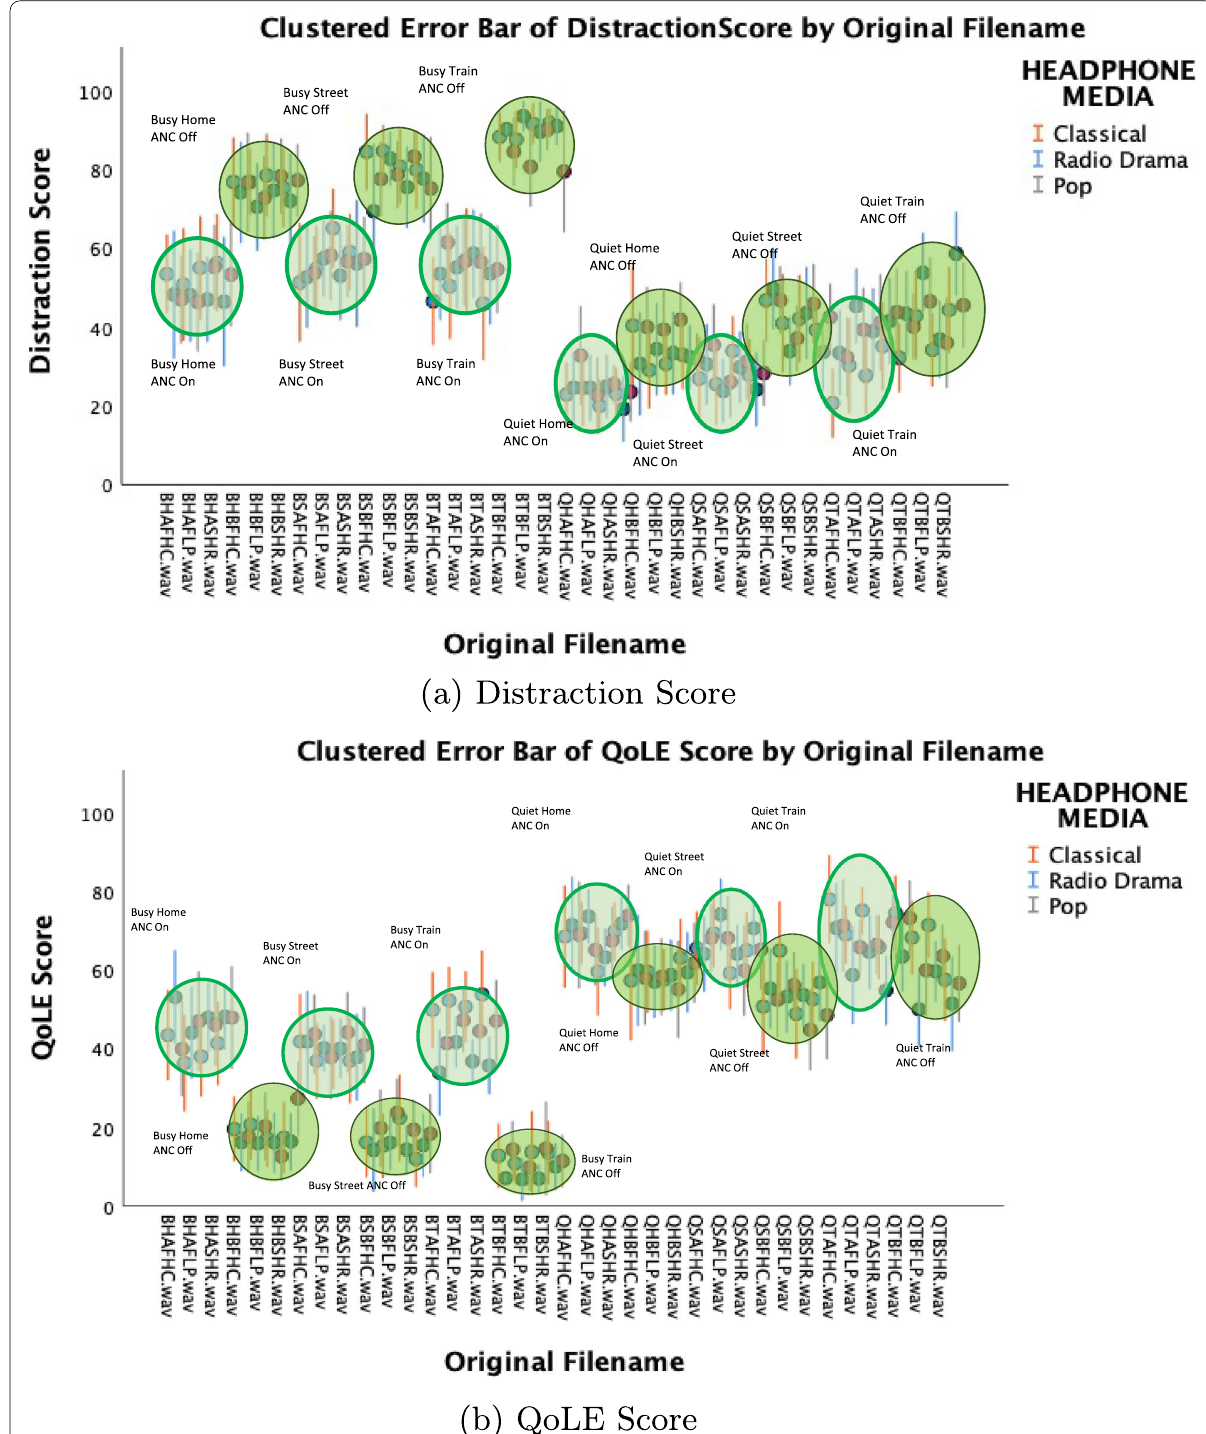
Fig. 3 Distraction and QoLE ratings across stimuli. This plot provides the variation of the distraction and QoLE ratings through all the stimuli, and labels have been provided to show the variations of the ratings across various stimuli and parameters. The green circle signifies ANC Off, and blue circle signifies ANC